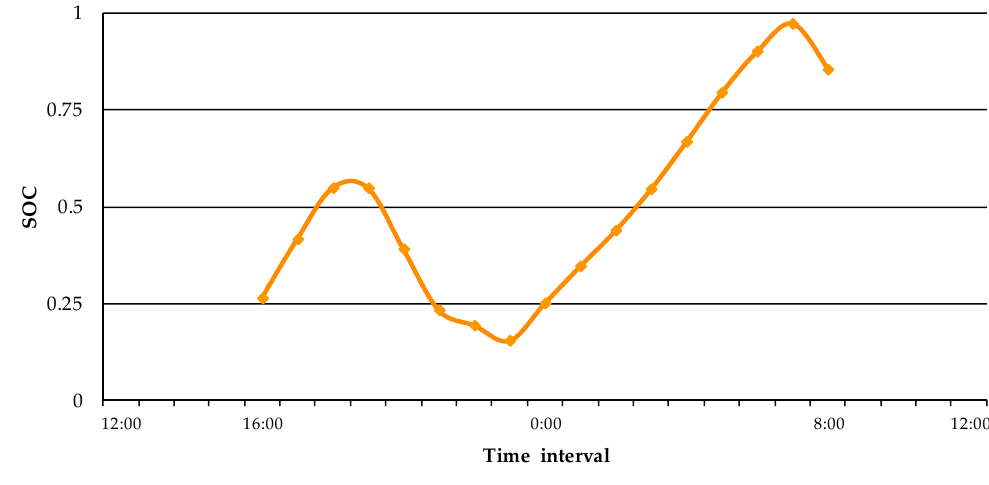
Figure 6. Daily SOC curve of a typical EV.